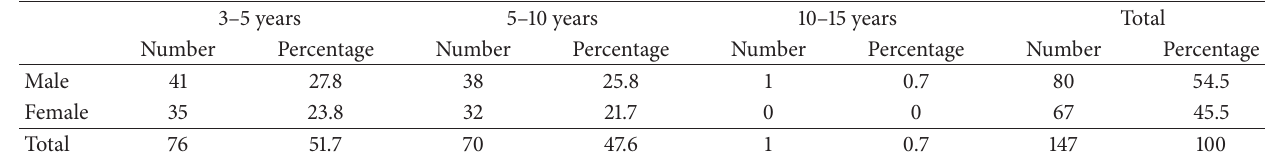
Table 1: Age and sex distribution of the patients.